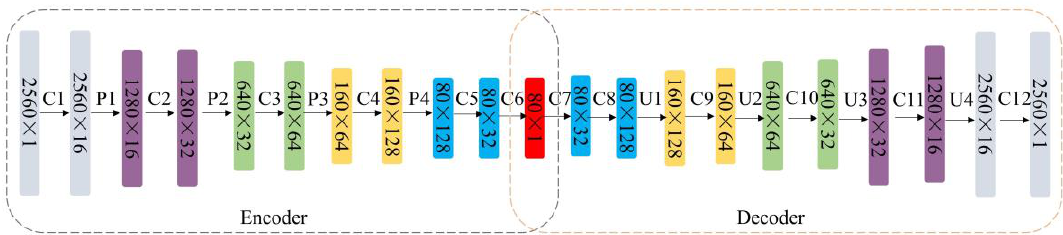
Figure 8. DCAE structure diagram.